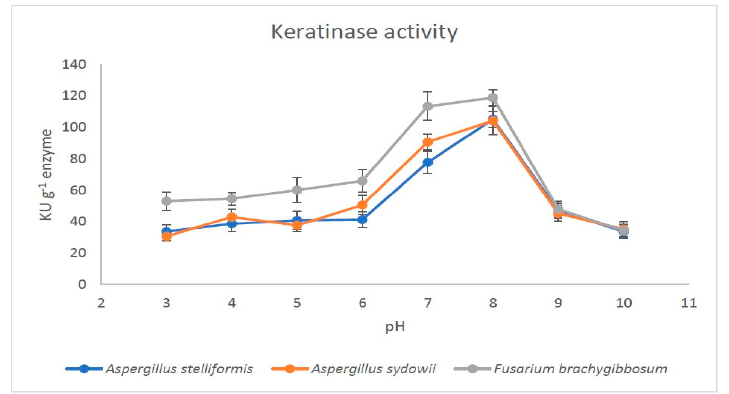
Figure 3. Phylogenetic tree generated from MP analysis based on ITS sequence data of F. brachygibbosum AUMC 10937 associated to other related genes in Nectriaceae. Blue color refers to the species in this study. Bootstrap support values (100 replications) for ML/MP combination equal to or greater than 50% are indicated at the respective nodes. The tree is rooted to Paracremonium inflatum CBS 485.77 as the out group.